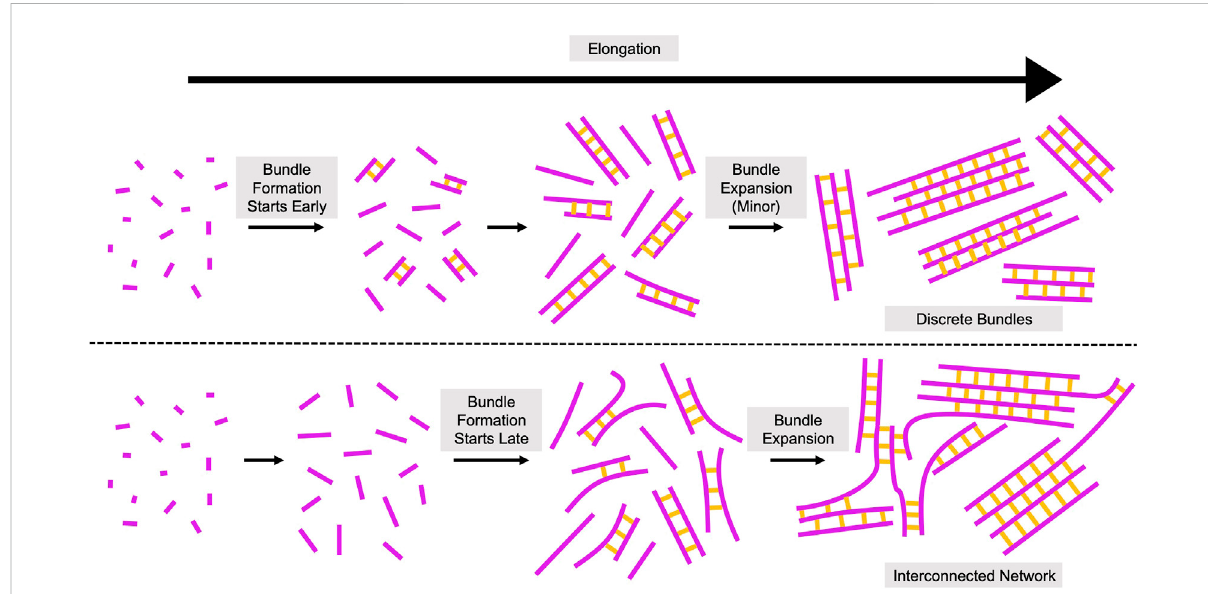
FIGURE 7 Assembly of Crosslinked Actin Structures from Elongating Filaments. Proposed model for the role of fi lament length in the assembly of actin bundles. Elongating actin fi laments and fascin-mediated crosslinks are depicted in magenta and yellow, respectively. Bundling occurs via two phases: bundle formation and bundle expansion. During bundle formation, individual fi laments become crosslinked together to form new bundles. During bundle expansion, pre-existing bundles incorporate additional fi laments and merge with other bundles. Initiation of fi lament bundling early in elongation (when fi laments are short) promotes the assembly of topologically discrete bundles (top). Initiation of bundling at later stages of elongation (when fi laments are longer) produces interconnected networks with irregular bundle morphologies